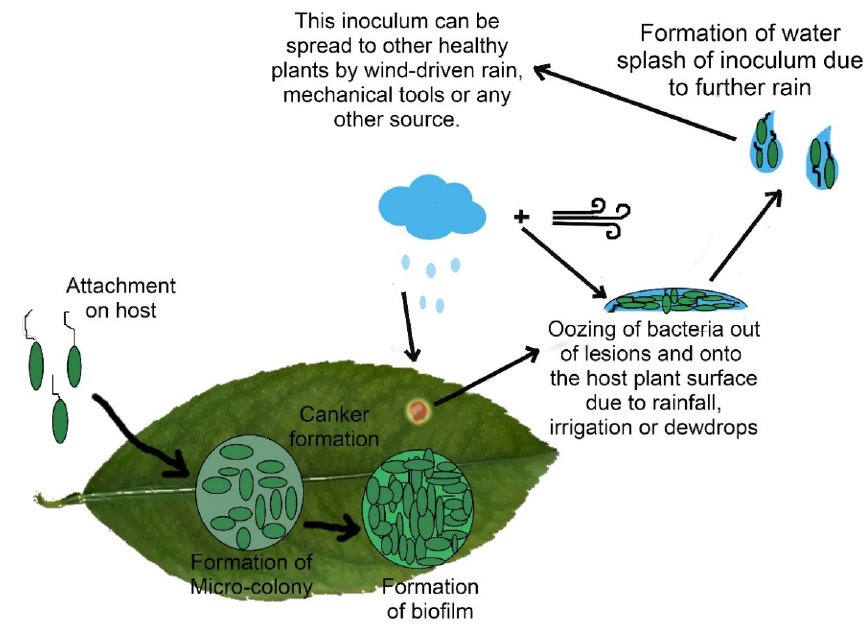
Figure 2. Stages of formation of biofilm and process of dissemination of inoculum.